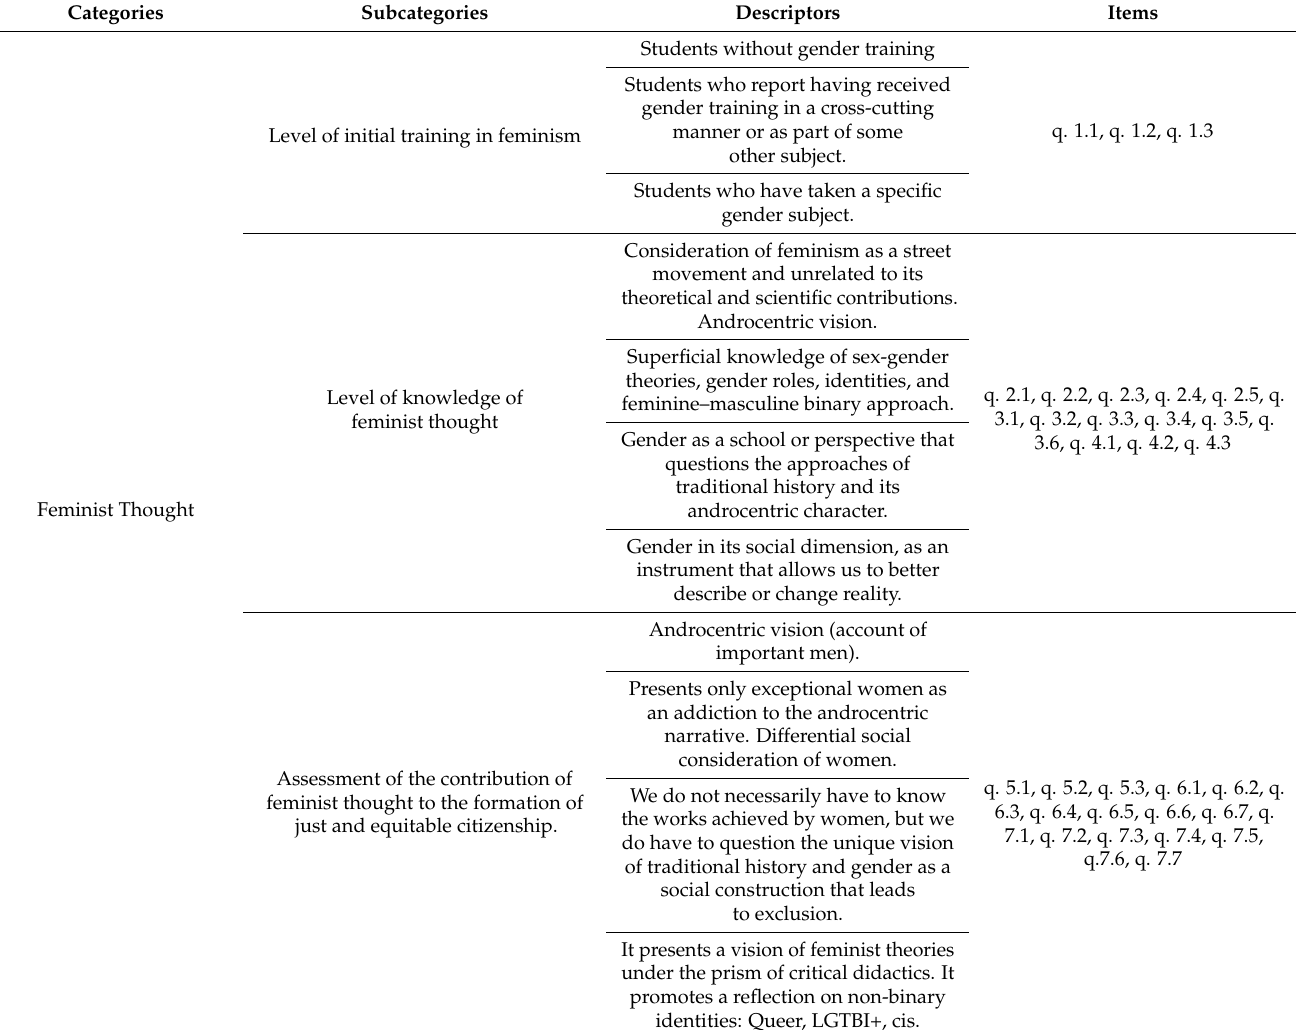
Table 1. Categories, subcategories and descriptors of the study. Source: own elaboration.